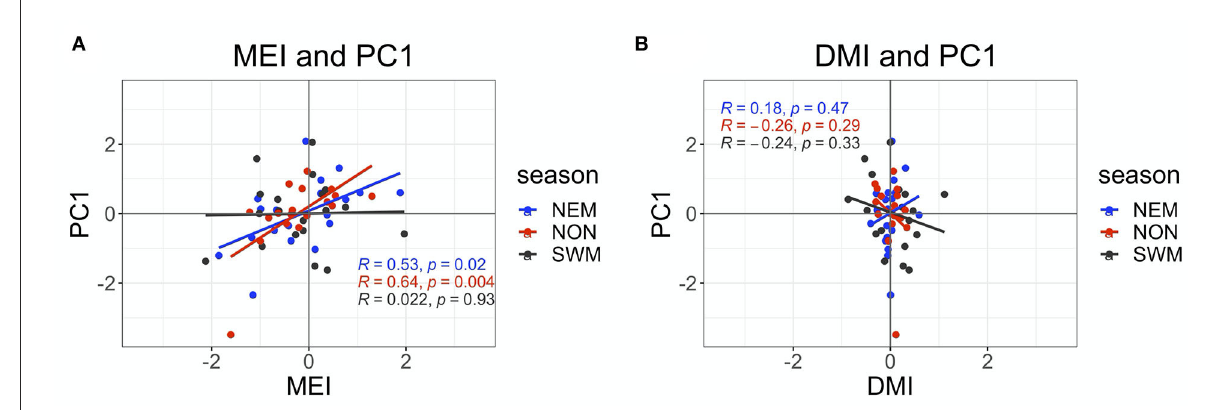
FIGURE7 Scatter plots between seasonal averaged MEI (A) and DMI (B) with PC1 of all seasons during